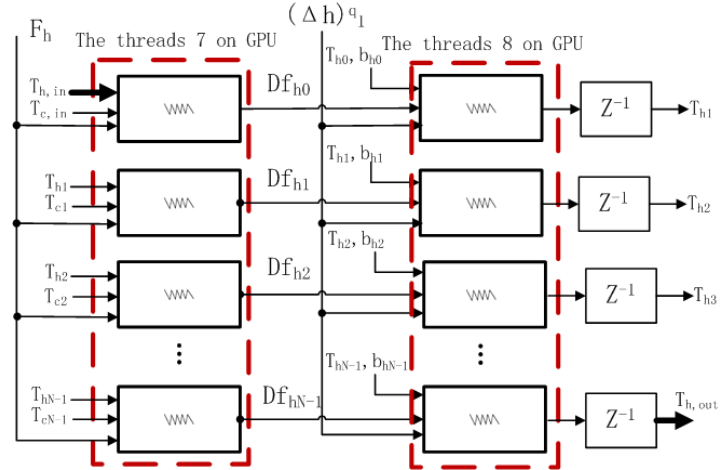
Figure 8. The thread blocks of the proposed parallel model in hot fluid for the parallel-flow heat